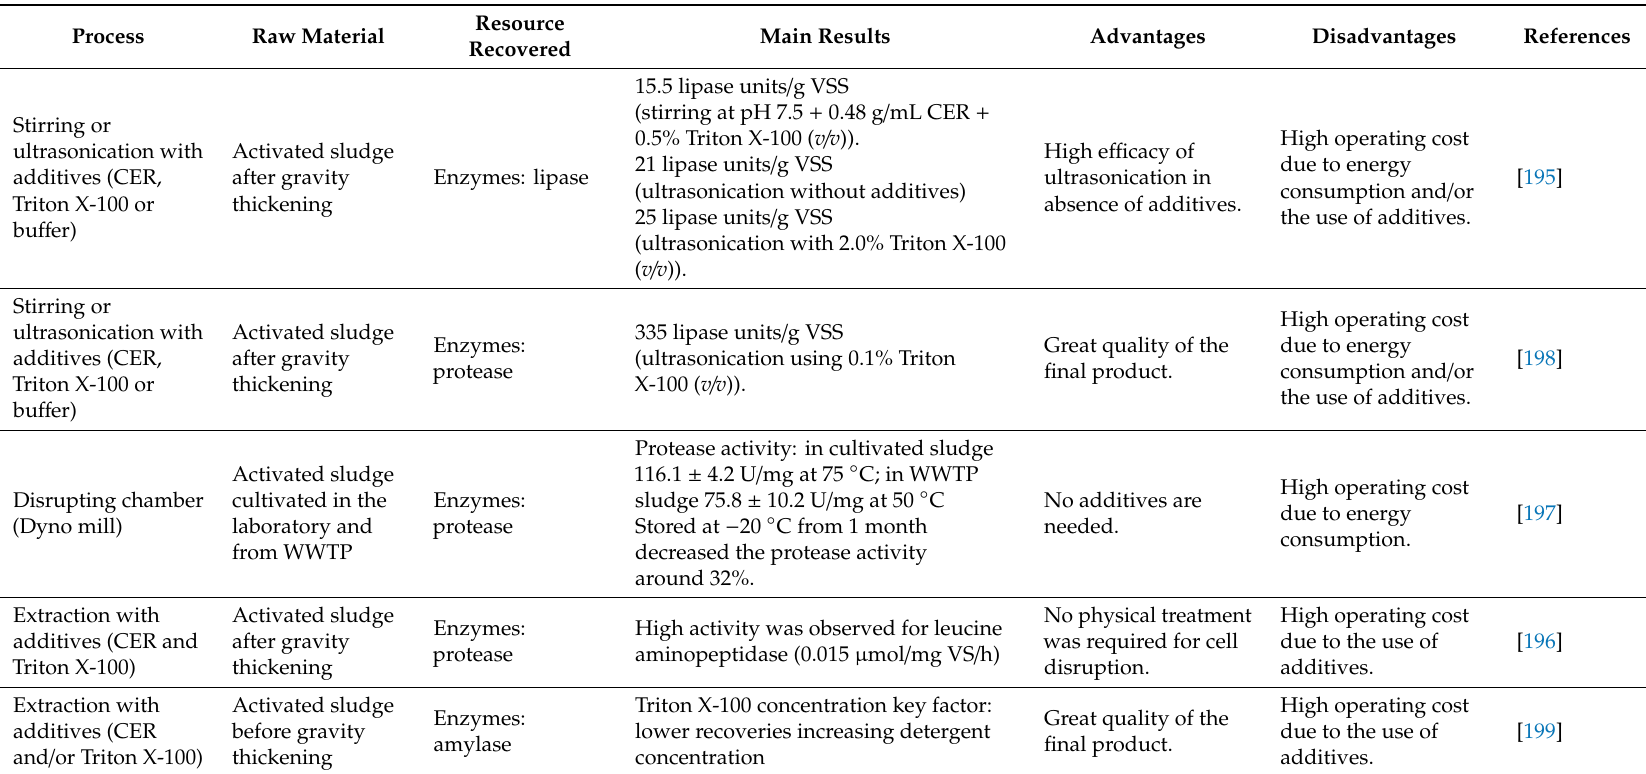
Table 10. Process employed for hydrolytic enzymes recovery from sewage